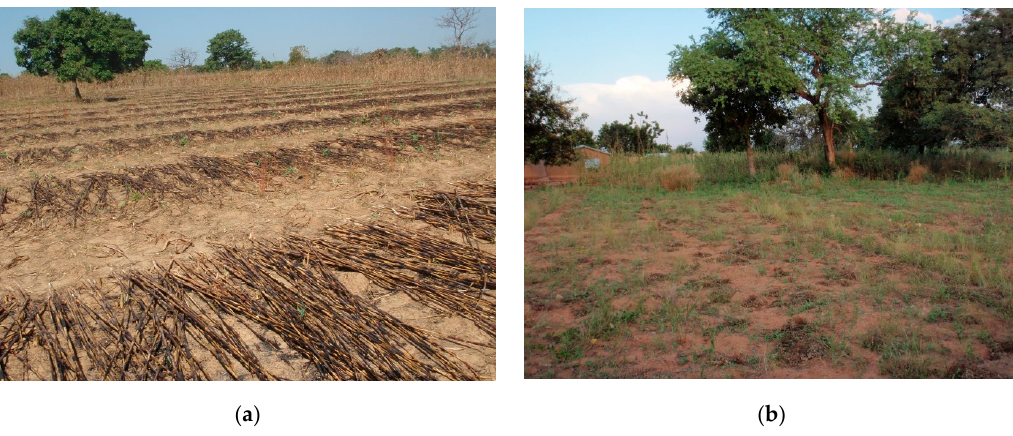
( a ) ( b ) Figure 7. ( a ) Harvested sorghum field in Dano (Burkina Faso) with the sorghum stalks cut down and ready to be transported; and ( b ) a harvested groundnut field in Vea (Ghana). Groundnut plants have been uprooted and transported home, leaving on a mixture of bare patches and grasses.